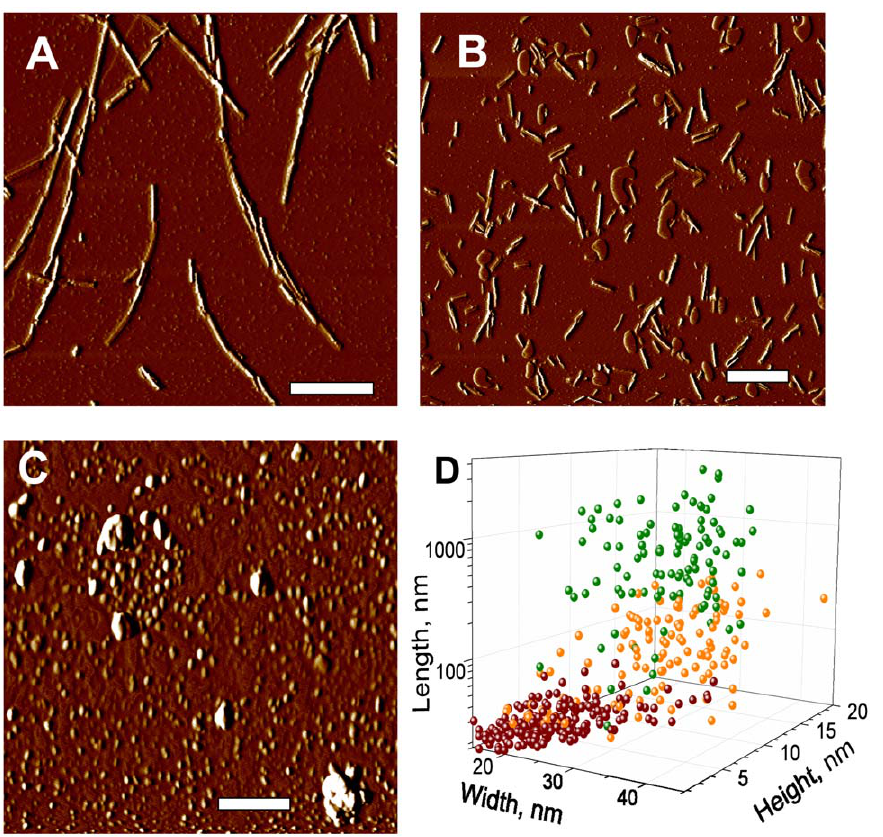
Figure 9. AFM imaging of rPrP fibril fragmentation. AFM imaging of intact rPrP fibrils ( A ) and fibrils sonicated for 30 sec in the absence ( B ) or presence of 5 small beads ( C ) using sonication conditions identical to those used in PMCA. Scale bars =0.5 m m. ( D ) Analysis of length, width and height for intact rPrP fibrils ( green circles ) and fibrils sonicated in the absence ( orange circles ) or presence of 5 small beads ( red circles) .